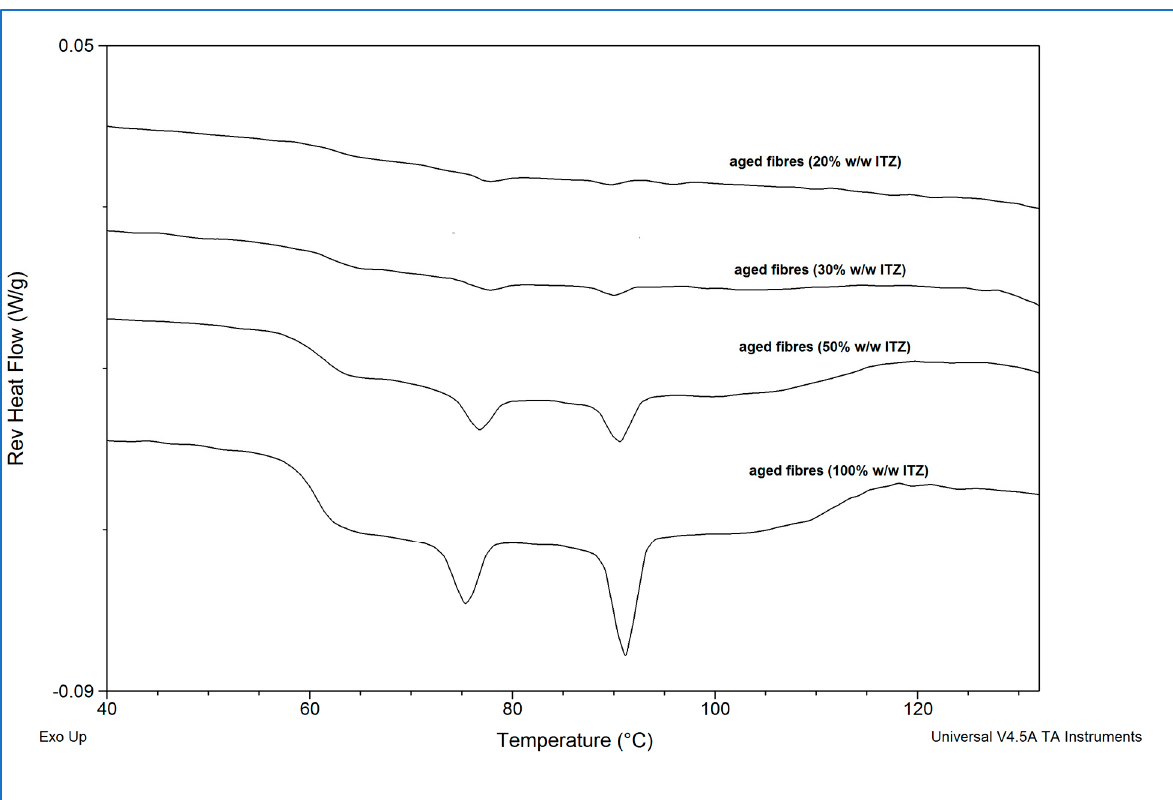
Figure 5. Reversing heat flow traces of itraconazole-loaded sucrose microfibres (containing 20, 30, and 50% w / w itraconazole) and pure itraconazole microfibres after 30 days exposure to 25 °C/75% RH. (ITZ = itraconazole).